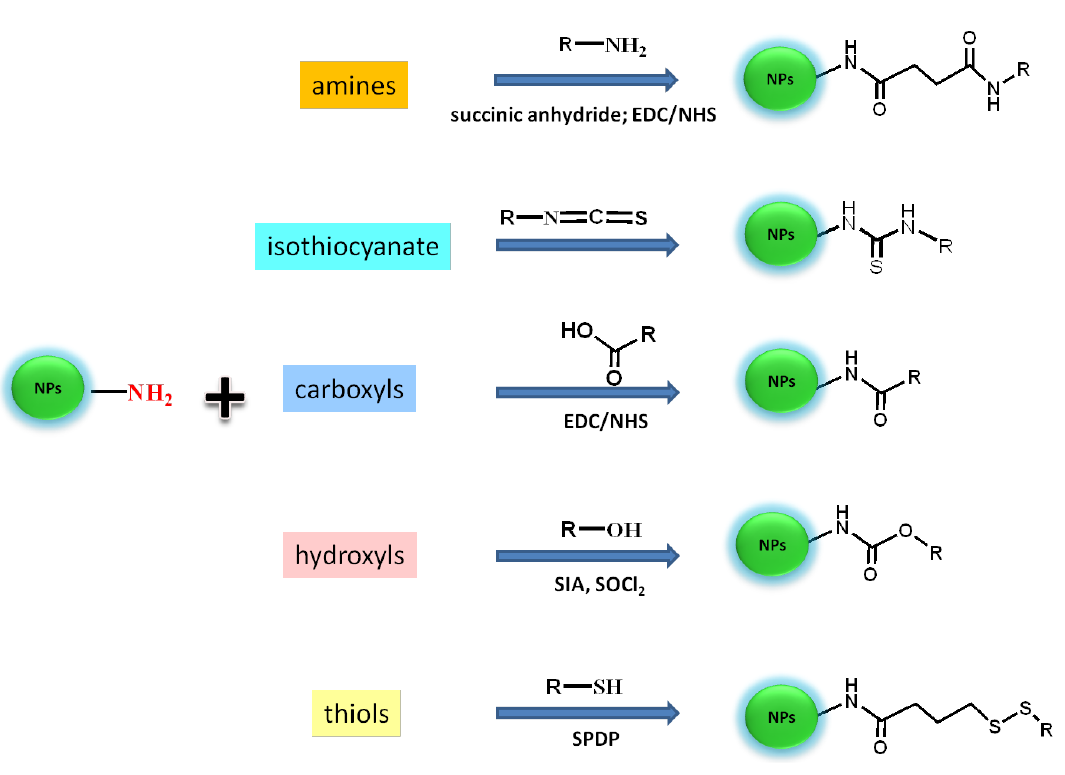
Figure 9. Bioconjugation schemes for the attachment of bio(molecules) (R) presenting different target sites (amines, carboxyl, hydroxyl, thiols, isothiocyanate) onto the surface of amine-coated-UPNPs. Reagents: 1-ethyl-3-(3-dimethylaminopropyl) carbodiimide hydrochloride (EDC), succinimidyl ester (NHS), succinimidyl iodo acetate (SIA), N -succinimidyl 3-(2-pyridyldithio) propionate